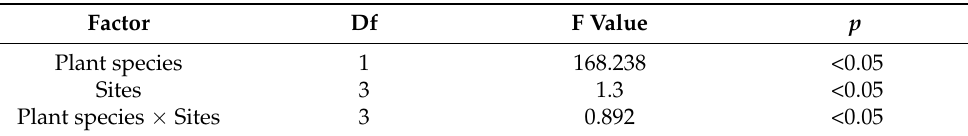
Table 2. Summary of the ANOVA for the effect of plant species and location of the samples on value Figure 6. Dependence of the carbon isotope composition on mass loss. δ13C in plant residuals.